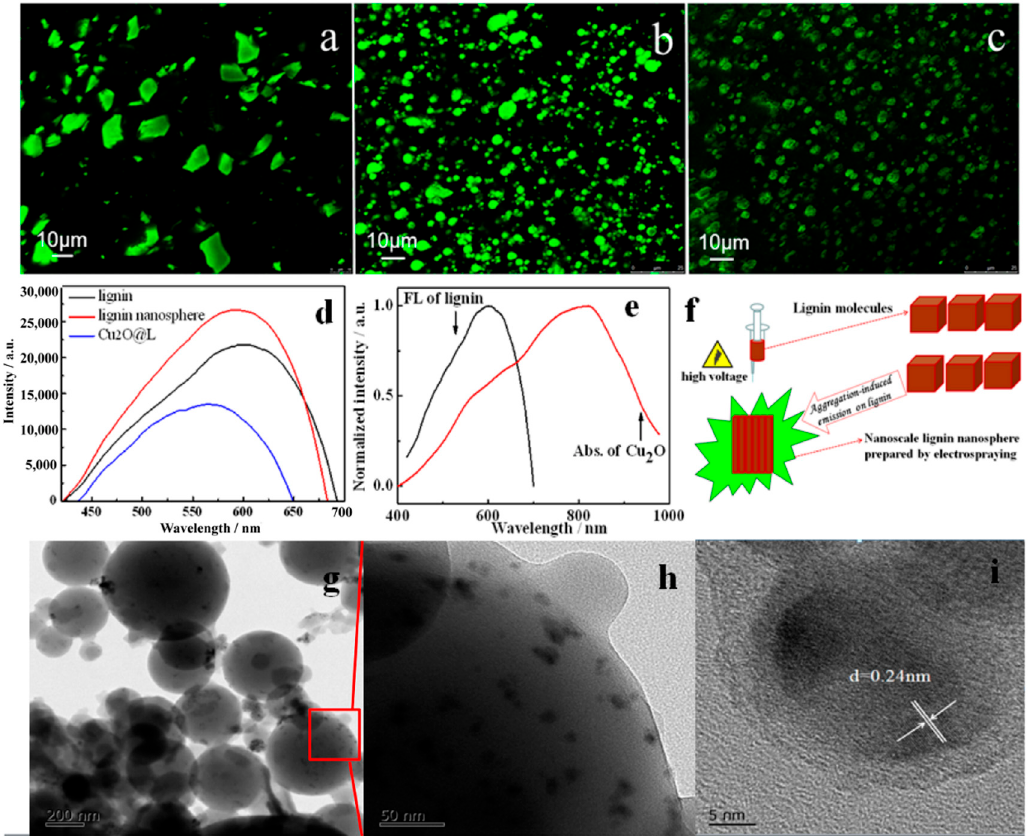
Figure 2. LSCM images, fluorescence spectra, UV–vis–NIR absorption, and TEM images of samples: ( a ) LSCM image of raw lignin; ( b ) LSCM image of lignin nanospheres; ( c ) LSCM image of raw Cu 2 O@L; ( d ) fluorescence spectra of lignin, lignin nanospheres, and Cu 2 O@L; ( e ) UV–vis–NIR absorption of Cu 2 O and lignin; ( f ) proposed aggregation-induced emission of lignin nanospheres prepared by electrospraying; ( g ) TEM image of Cu 2 O@L; ( h ) the expansion of a certain part of image of g, and ( i ) HRTEM image of the nanoparticles on lignin nanospheres.